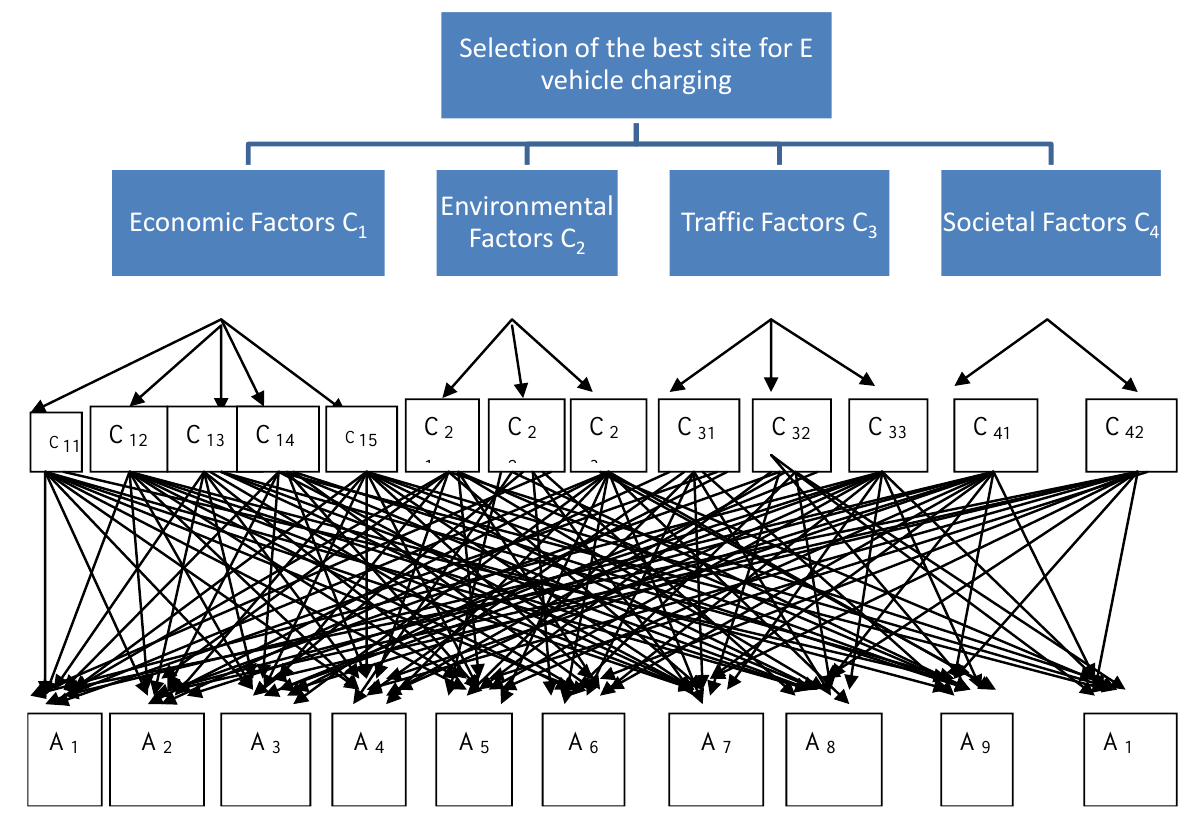
Figure 3. Hierarchical structure of the problem. Table 2. Alternatives selected in the study and their corresponding nearby location, latitude and longitude.